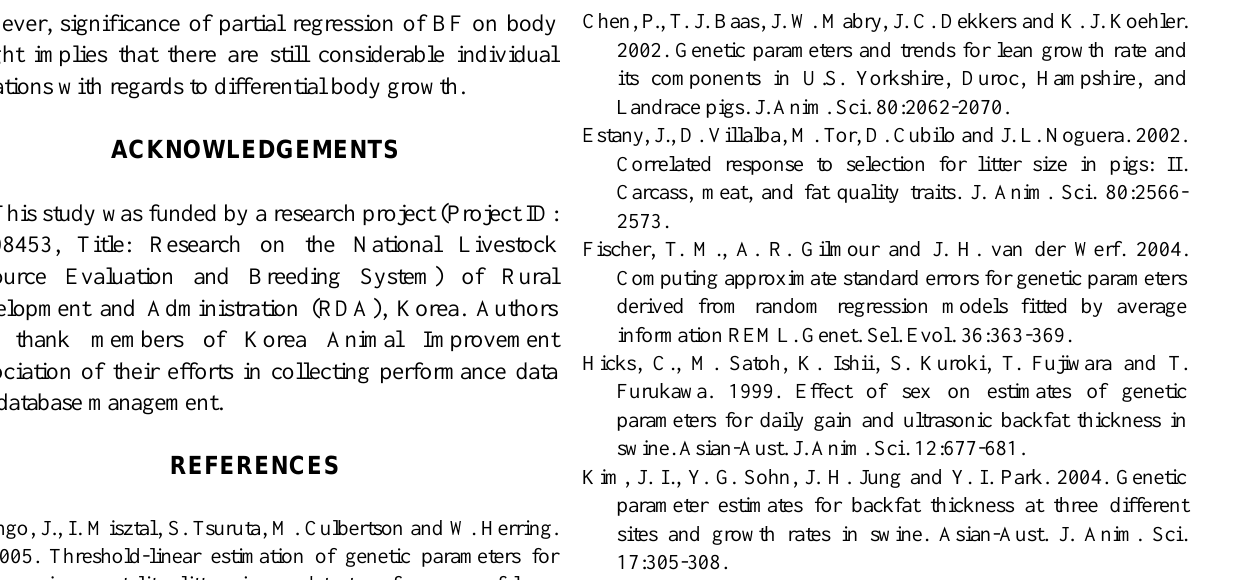
Figure 1. Genetic trends of days to 90 kg and ultrasound traits(scales on left vertical axis) with average inbreeding coefficients (aveF, scales on right vertical axis) by the year of births(BF = average EBV of backfat thickness; DAYS90 = average EBV of days to 90 kg body weight; EMA = average EBV of eye muscle area; RCP = average EBV of retail cut